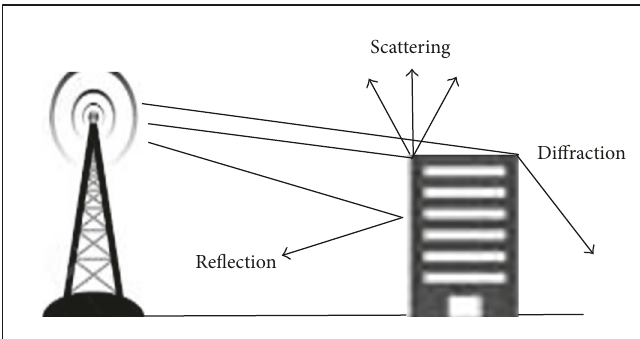
Figure 2: Propagation mechanisms in ray-tracing.